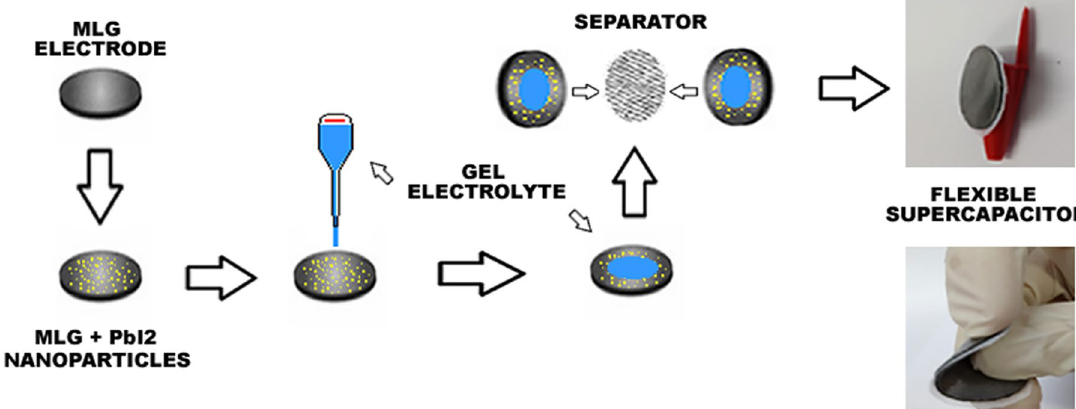
-NPs were spread over MLG flexible electrodes and stacked with 2 -NPs / MLG supercapacitor. The obtained supercapacitor has stretched 2